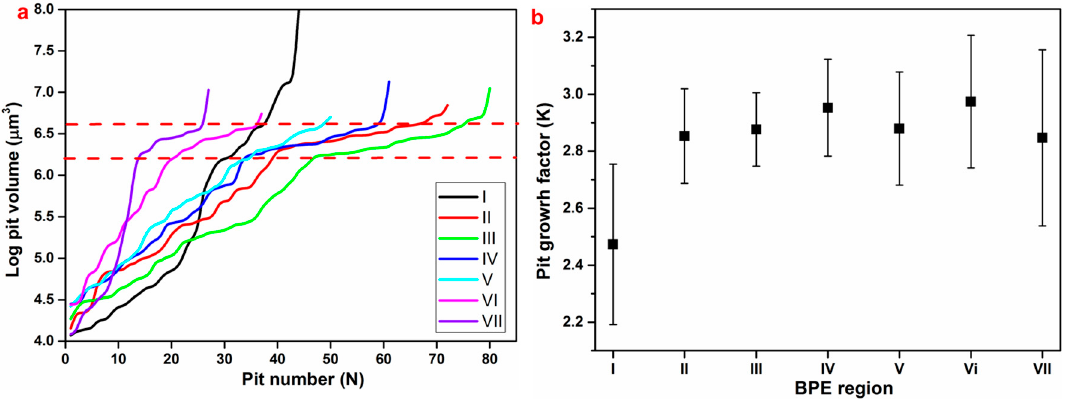
Figure 12. ( a ) The relationship between pit number and corresponding pit volumes, and ( b ) the corresponding pit growth factor (K) for each region (I ‐ VII) in Figure